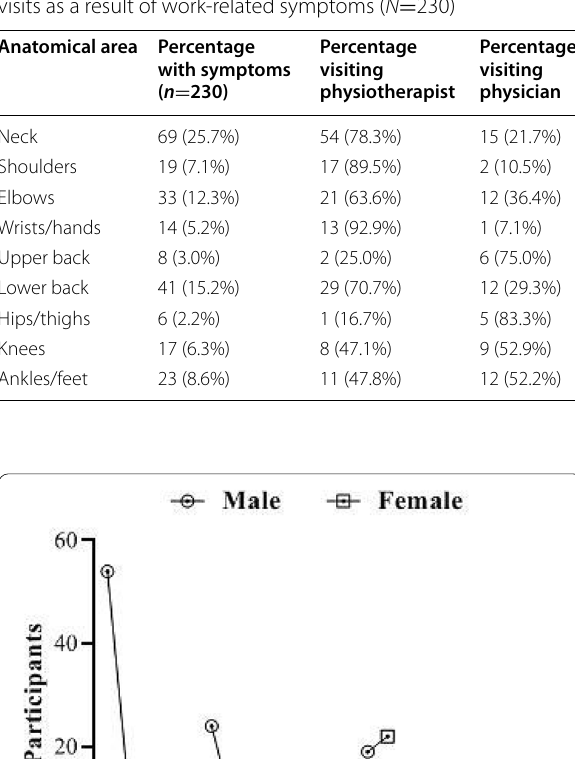
Table 2 Percentages of physical therapists reporting